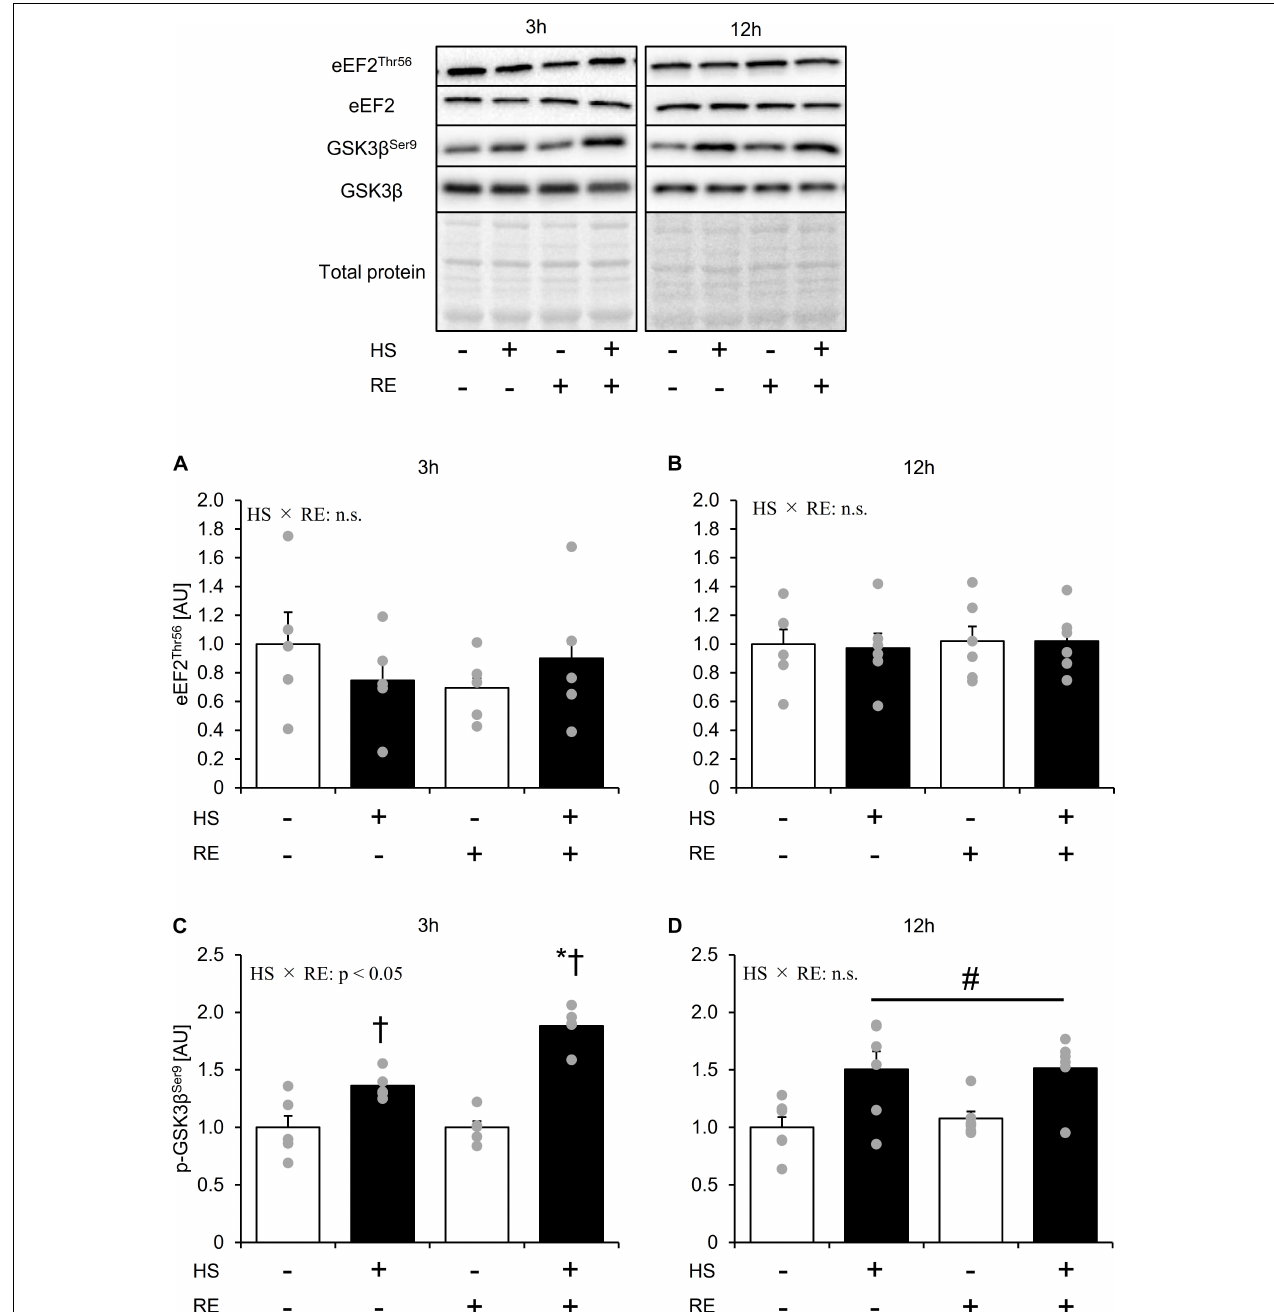
FIGURE 5 | The effect of an acute RE on mTORC-independent substrates related to the protein synthesis after 14 days of hindlimb suspension. Changes in the phosphorylation of eEF2 Thr56 in response to acute resistance exercise after hindlimb suspension (A,B) . Changes in the phosphorylation of GSK3 β Ser9 in response to acute resistance exercise after hindlimb suspension (C,D) . Values are means ± SE ( n = 5–6/group). Black line with # : main effect of HS ( p < 0.05). *: p < 0.05 vs. non-exercised control leg within each group. † : p < 0.05 vs. CON group within the same